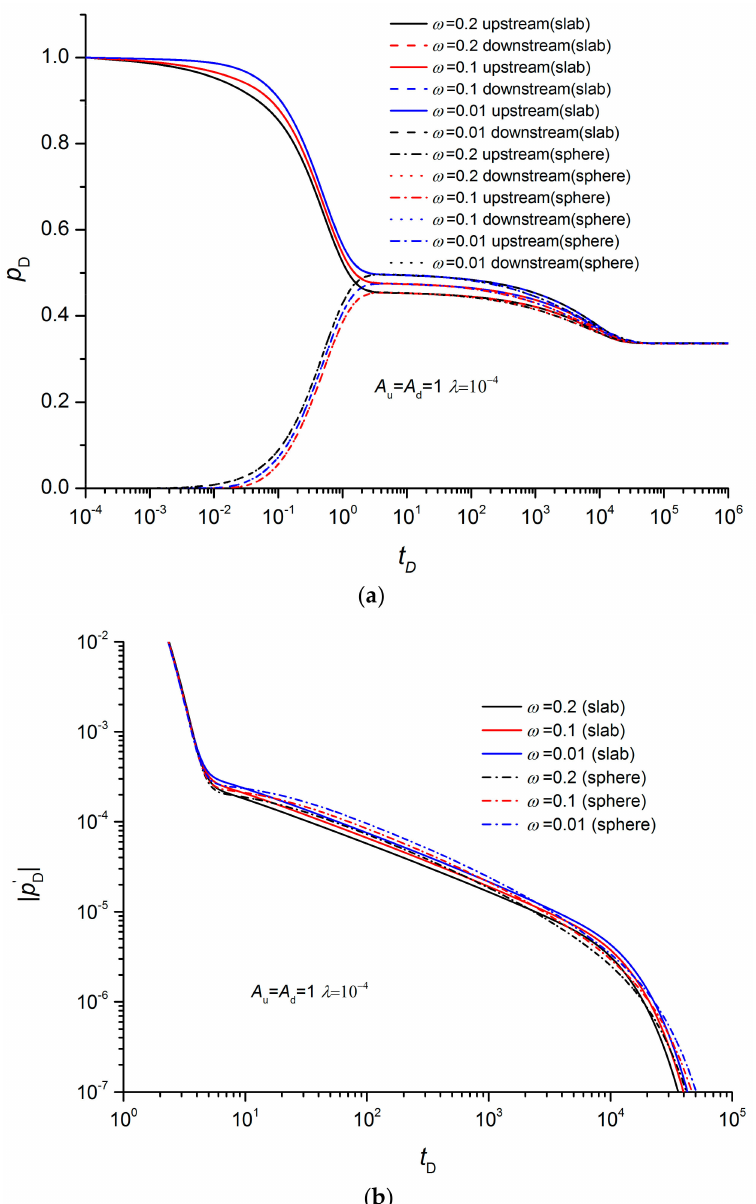
Figure 4. E ff ect of storativity ratio on pulse decay tests for dual-porosity cores. ( a ) Pressure history. ( b ) Pressure